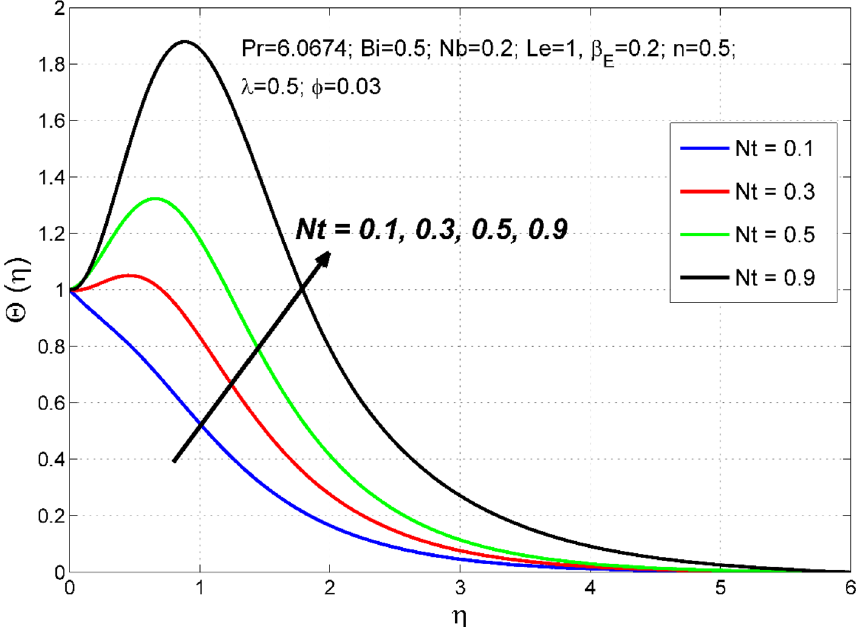
Figure 14. The nanoparticles volume fraction distribution �(η) behavior for the variation of the thermophoresis Nt